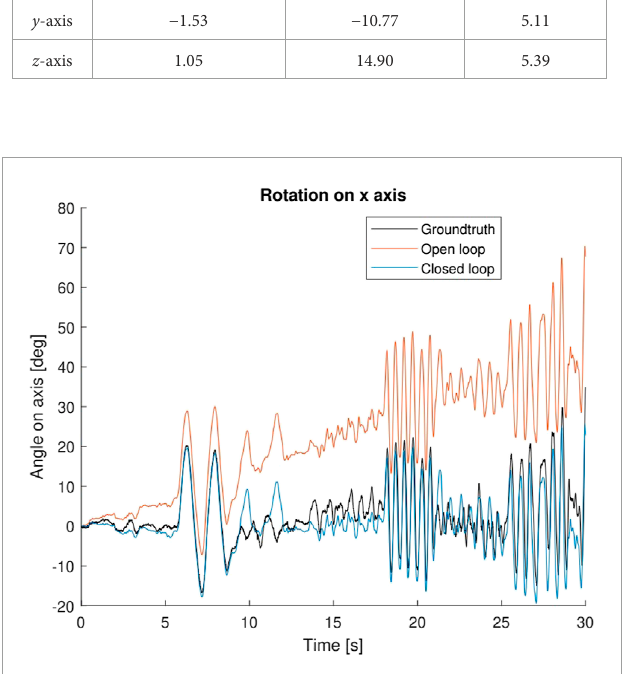
FIGURE 6 Comparison of the groundtruth (black) against the estimation of the open loop (orange) and closed loop (blue)